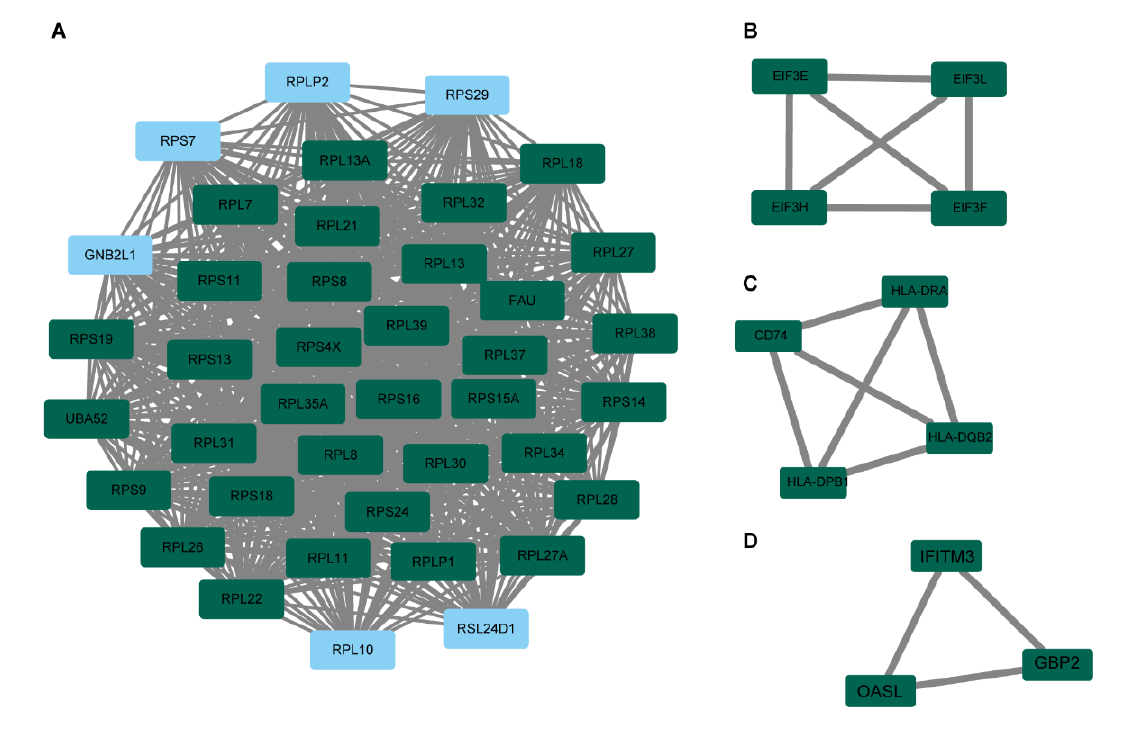
Figure 7. Analysis of protein–protein interaction networks of N gene set using the MCODE algorithm in STRING. ( A ) Cluster 1. ( B ) Cluster 2. ( C ) Cluster 3. ( D ) Cluster 4. The color green indicates the hub genes.